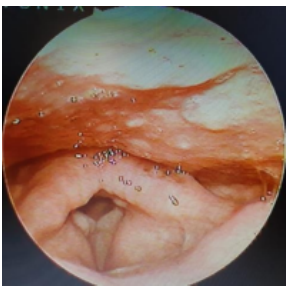
Figure 16. Reinke’s edema resulting in anterior glottic chink